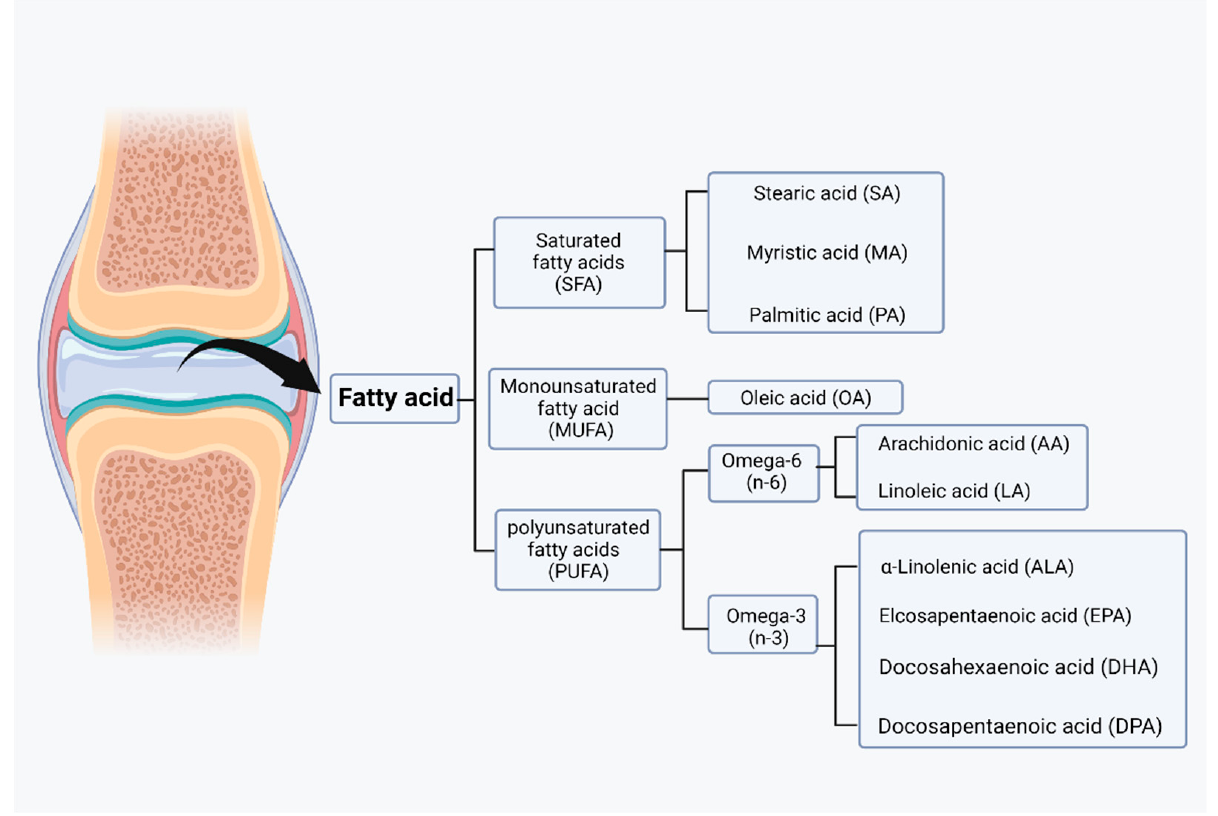
Figure 3. Classification of fatty acids in joint. Based on the degree of saturation, fatty acids can be categorized as saturated fatty acids (SFAs), monounsaturated fatty acids (MUFAs), or polyunsaturated fatty acid (PUFAs). Those fatty acids can be further categorized into lower grades. (Figure was created with Biorender.com and accessed 20 September 2022).